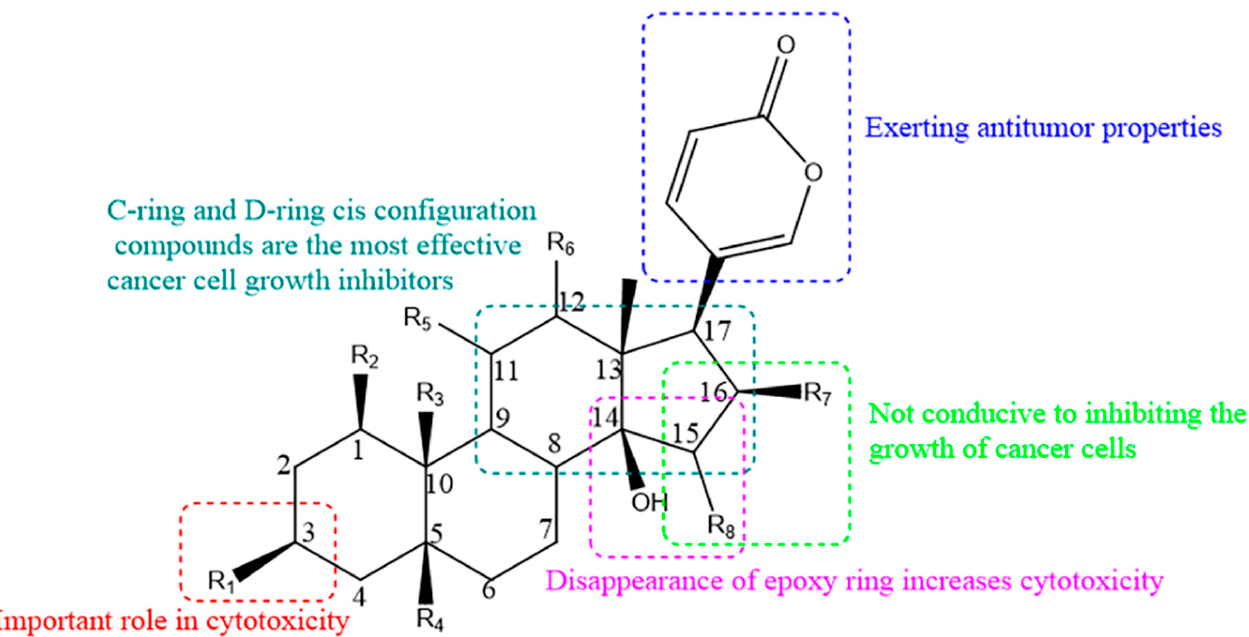
Figure 3. Structure–activity relationship diagram of bufadienolides.